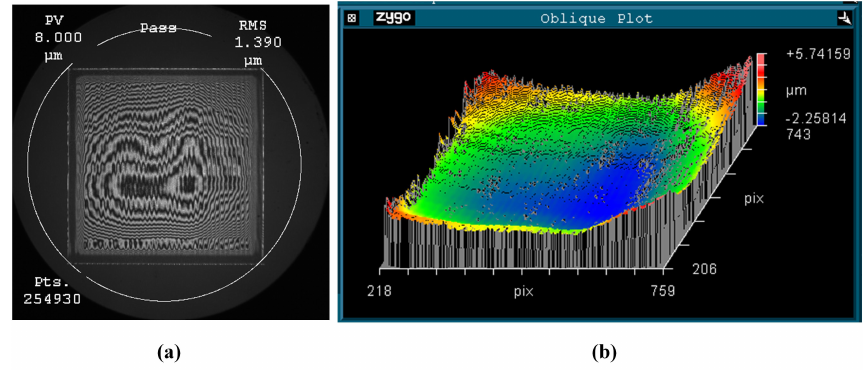
Figure 9. Measured results of the surface after three times of pre-polishing. ( a ) interference fringe image and ( b ) surface form error